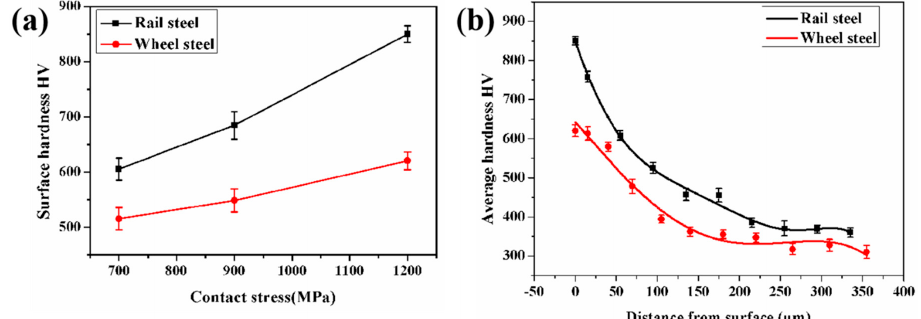
Figure 6. The variation of the hardness of wheel and rail samples. ( a ) Surface hardness under different contact stress conditions. ( b ) The hardness profile of wheel-rail samples from surface to matrix under a contact stress of 1200 MPa.